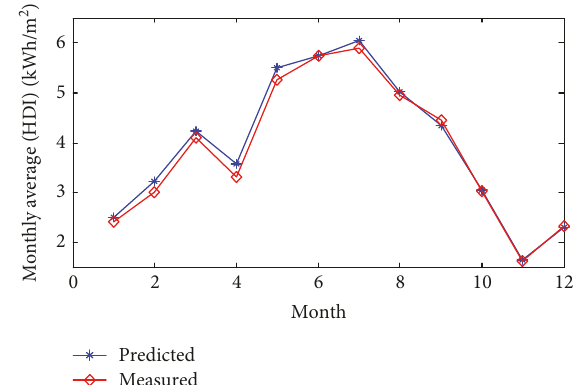
Figure 10: Comparison between the monthly averages of measured and predicted horizontal direct irradiation (HDI).